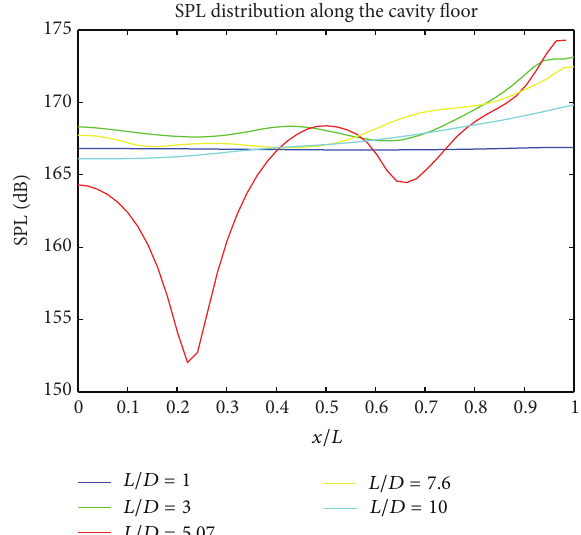
layer and cavity wall. The highest SPL values are obtained at the cavity rear wall for all